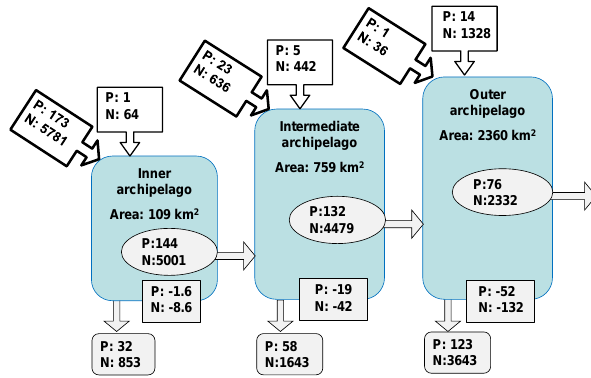
Figure 9. Transport scheme of N and P (tyr − 1 ) from land (tilted top boxes) and atmosphere (top boxes), as well as the net exchange from the inner, intermediate and outer archipelago (ellipse) towards the open sea. Total retention is the sum of temporary retention (square) and permanent retention (square with round corners). For P, burial is the only process that leads to permanent retention, while for N denitrification also removes N. Negative values for the temporary retention mean a decrease in the benthic and/or pelagic pools of